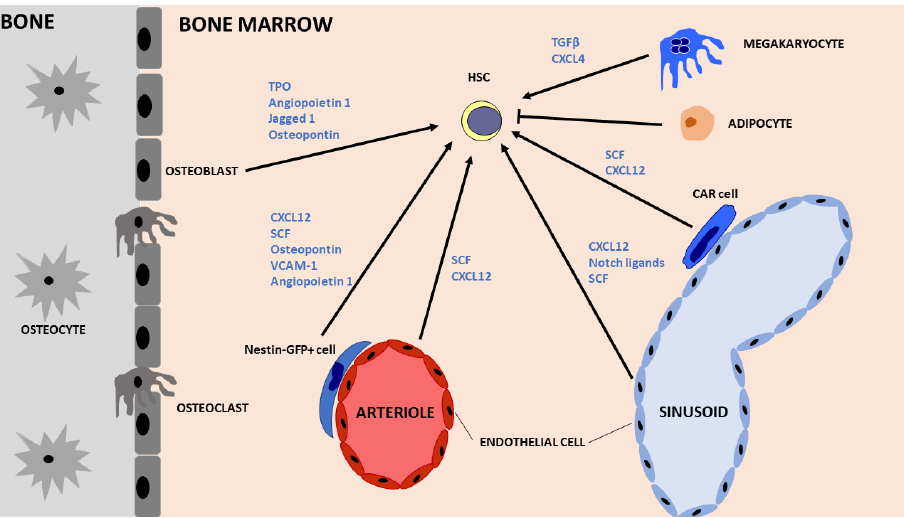
Figure 2. Schematic representation of the bone marrow niche showing the main components and key cytokines/factors implicated in HSC maintenance and self-renewal. HSCs have been found to localise close to arterioles and sinusoids (vascular niche) as well as close to the endosteum (endosteal niche). Nestin-GFP+ cells are perivascular cells highly enriched in MSCs while CXCL12-abundant reticular (CAR) stromal cells are adipo-osteogenic progenitors located in close proximity to sinusoids. HSC = Hematopoietic stem cell, TPO = Thrombopoietin, SCF = Stem cell factor, CXCL12 = C-X-C motif chemokine ligand 12, TGF- β = Transforming growth factor beta, CXCL4 = C-X-C motif chemokine ligand 4.